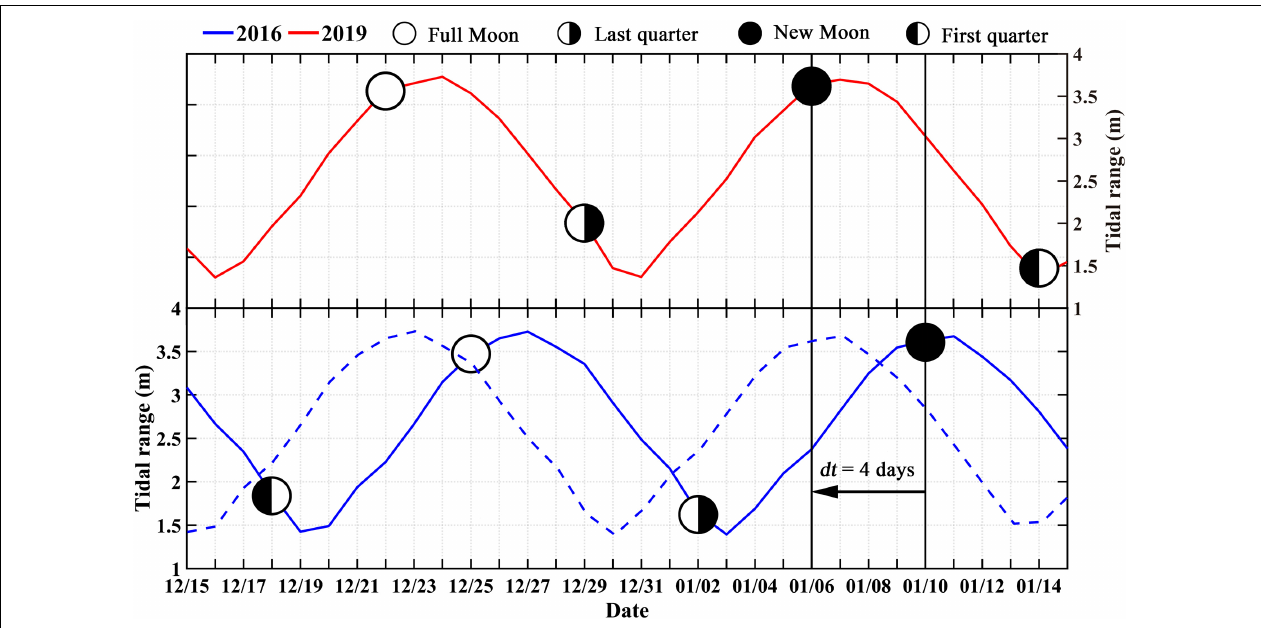
FIGURE 2 | Schematics showing the algorithm used to generate the tide-related daily climatological Chl- a dataset. The blue dashed line stands for the Chl- a time series after the date adjustment based on the phase differences of the spring-neap tidal cycles.